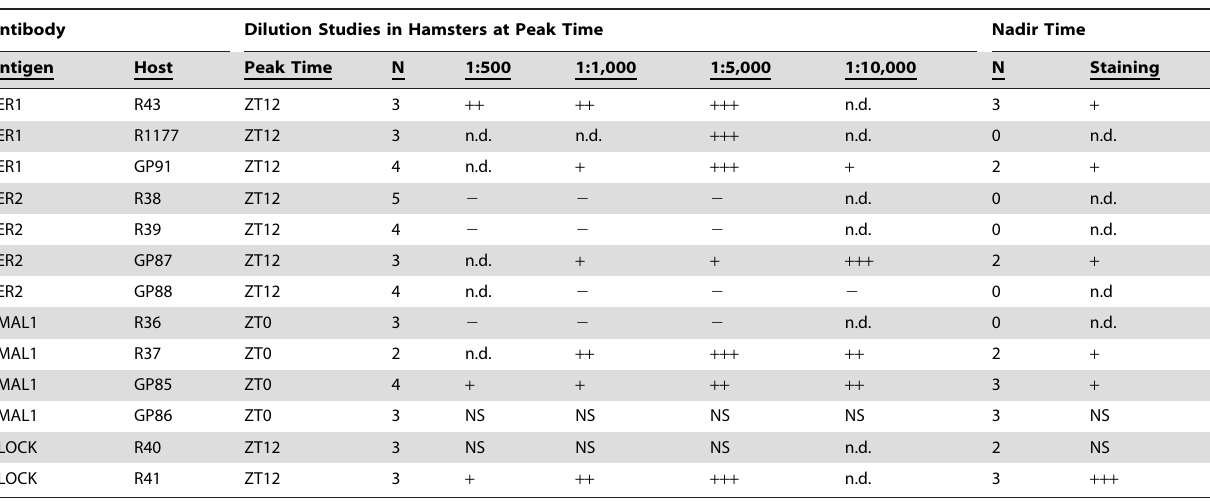
few cells in the central SCN. No staining was detected with R43 in Per1 2 / 2 mice. Table 3. Summary of Immunostaining Results in